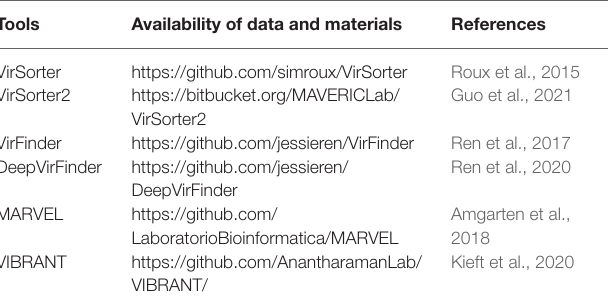
TABLE 1 | The available data and materials for prediction of pathogens and epidemiology.